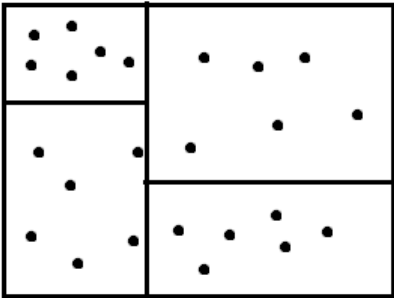
Figure 1. Dividing a graph with the help of RCB in equal sub-domains.